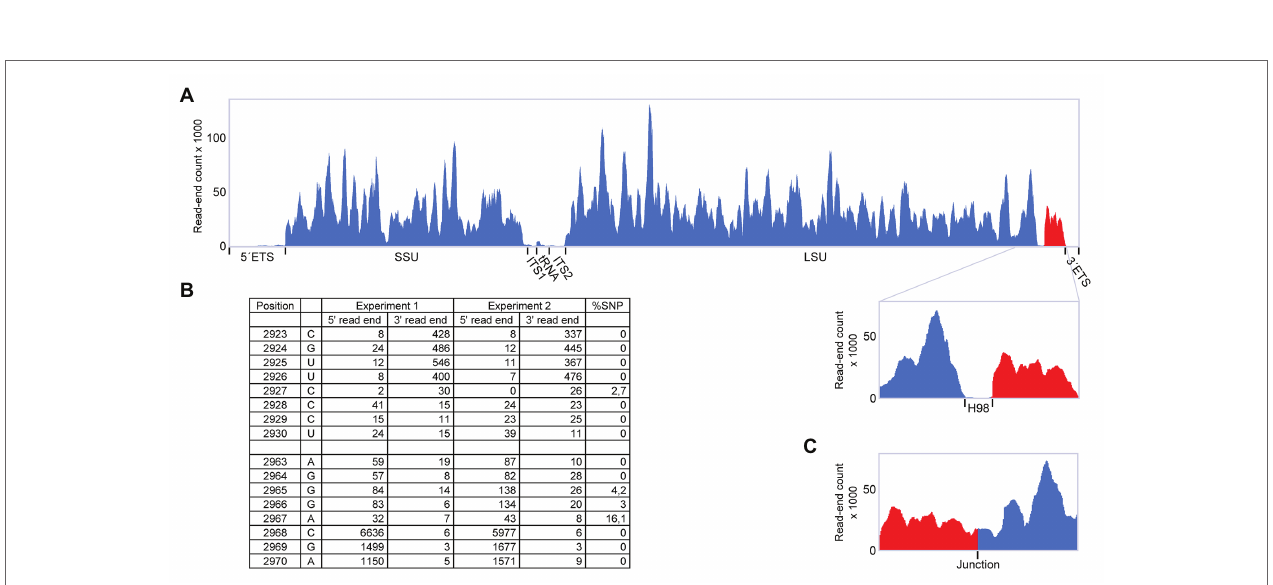
FIGURE 2 | RiboMeth-seq analysis of Pyrococcus furiosus rRNA. (A) Read-coverage of the entire rRNA operon using a linear reference sequence. The 5 ´ and 3 ´ parts are in blue and red, respectively, to emphasize their rearrangement during circularization. (B) Table of actual read-end numbers at the borders of H98 showing the signature pattern for free ends at the H98 flanking regions. The fraction of single nucleotide polymorphisms (SNP) at read ends is shown in the rightmost column. (C) Read-coverage around the proposed circularization junction after re-mapping of the data in (A) using a circularized reference